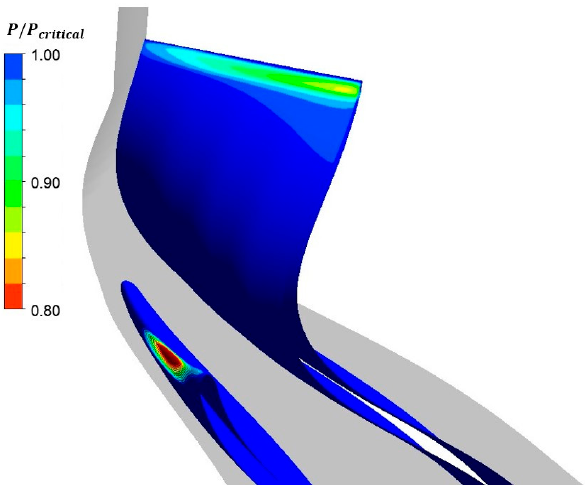
Figure 12. Contours of the local fl ow ratio of pressure to saturation pressure at the leading edge of the suction side.